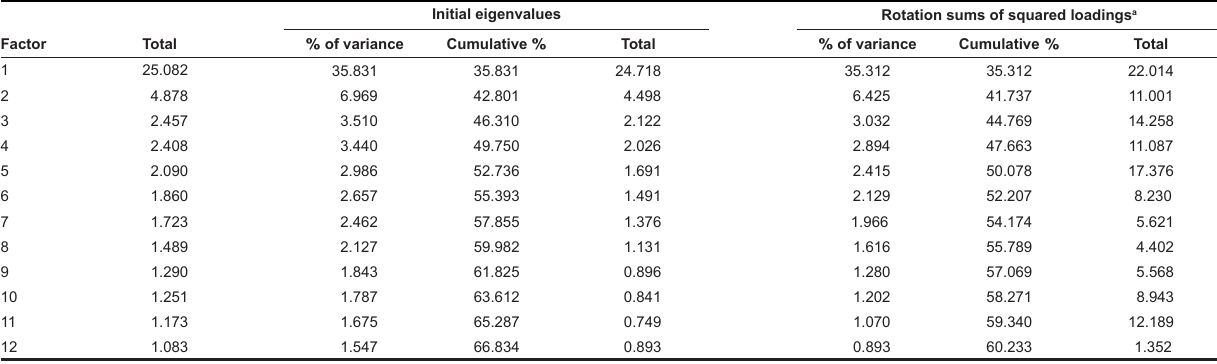
Table 9 Total variance explained for the 12-factor model after extraction (excluding factor with eigenvalues lower than